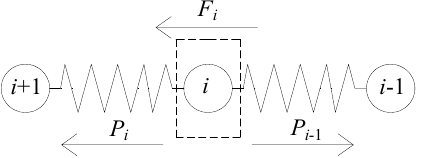
Figure 3. Force analysis diagram of the i th spring element.